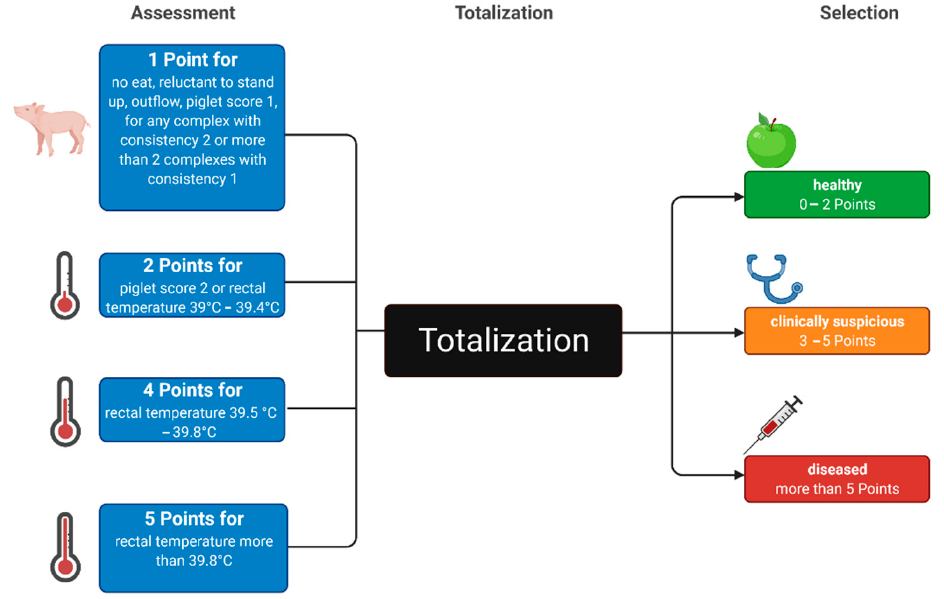
Figure 3. The way to bundle the clinical parameter (Figure was created with BioRender.com). Assessment: 1 point for not eating, reluctant to stand up, purulent discharge, piglet score 1, for any complex with consistency 2 or more than 2 complexes with consistency 1; 2 Points for piglet score 2 or rectal temperature 39 °C–39.4 °C; 4 points for rectal temperature 39.5 °C–39.8 °C; 5 points for rectal temperature more than 39.8 °C; Highscore were 11.